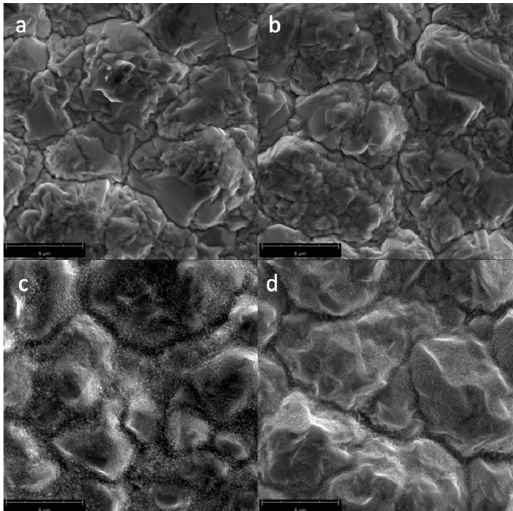
Figure 5. SEM micrographs of the surfaces of the Cu samples (magnified at 10,000×) subjected to varying pulsed oxygen plasmas with duty cycles: ( a ) untreated; ( b ) no pulsing; ( c ) 50%; and ( d )